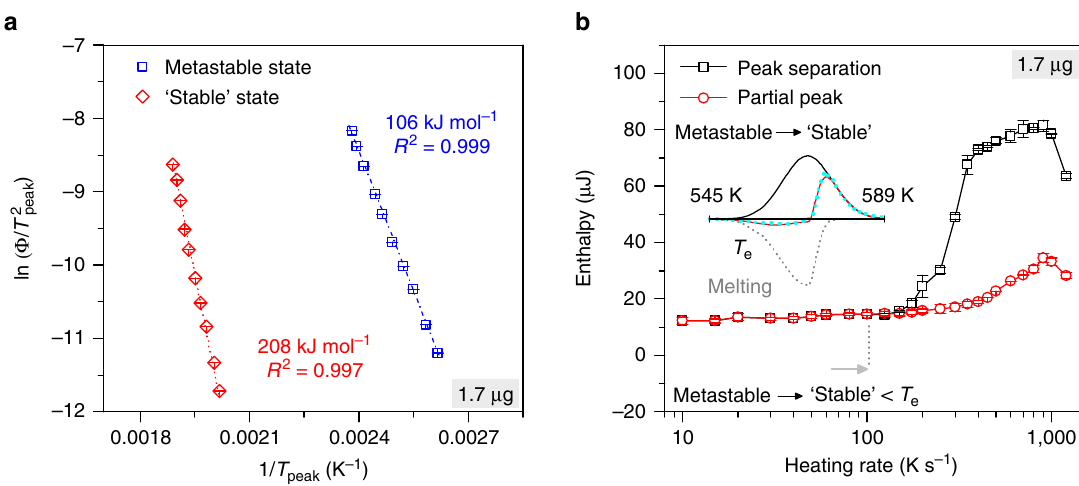
, where F is the heating rate and peak